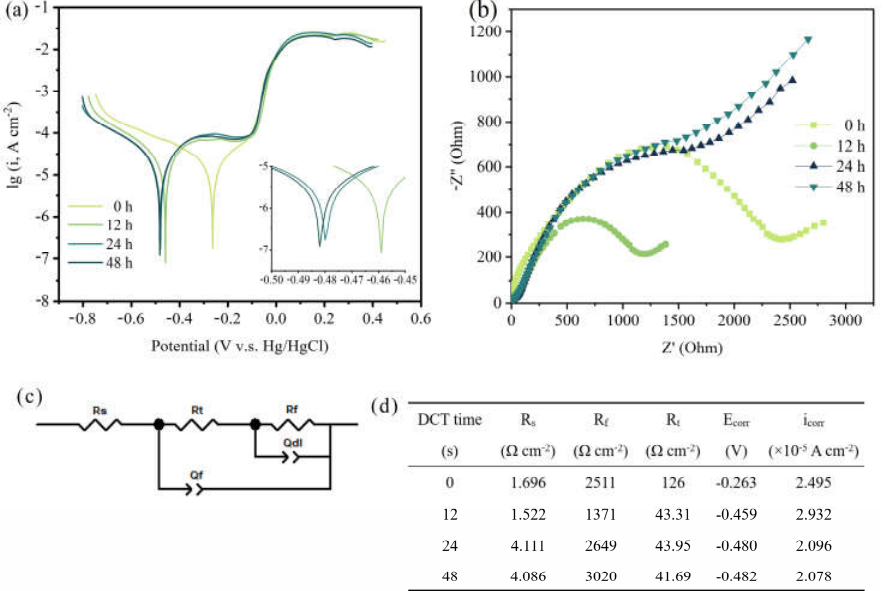
Figure 3. Corrosion resistance of ( a ) potentiodynamic polarization curves in the Tafel region, ( b ) the EIS curve, ( c ) the electrical equivalent circuit model, and ( d ) the corresponding data obtained from the equivalent circuit model.